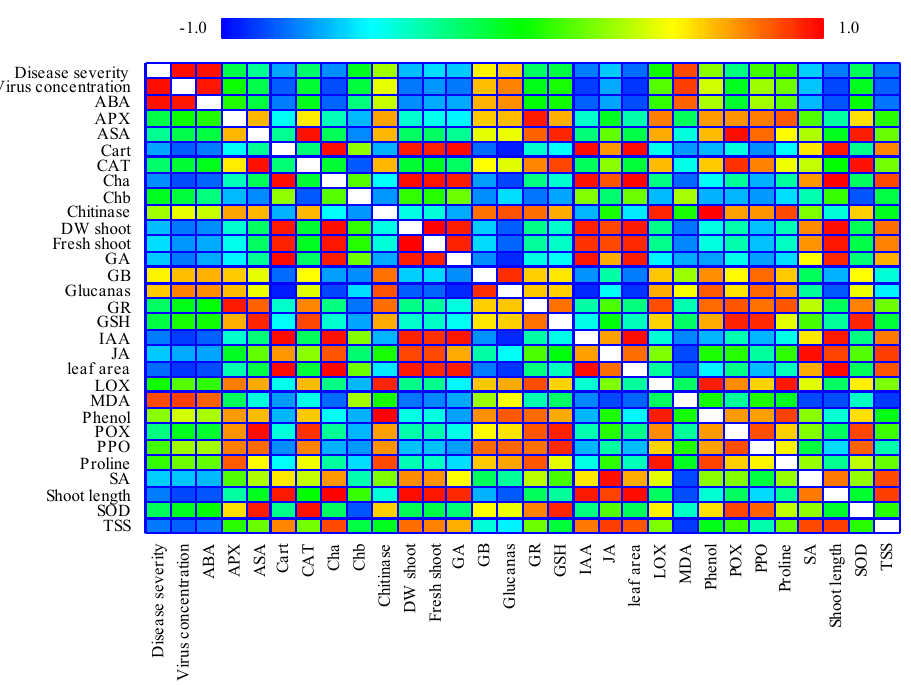
Figure 8. Heat map generated by Statgraphics XVII software Version 17.20 shows the relationship